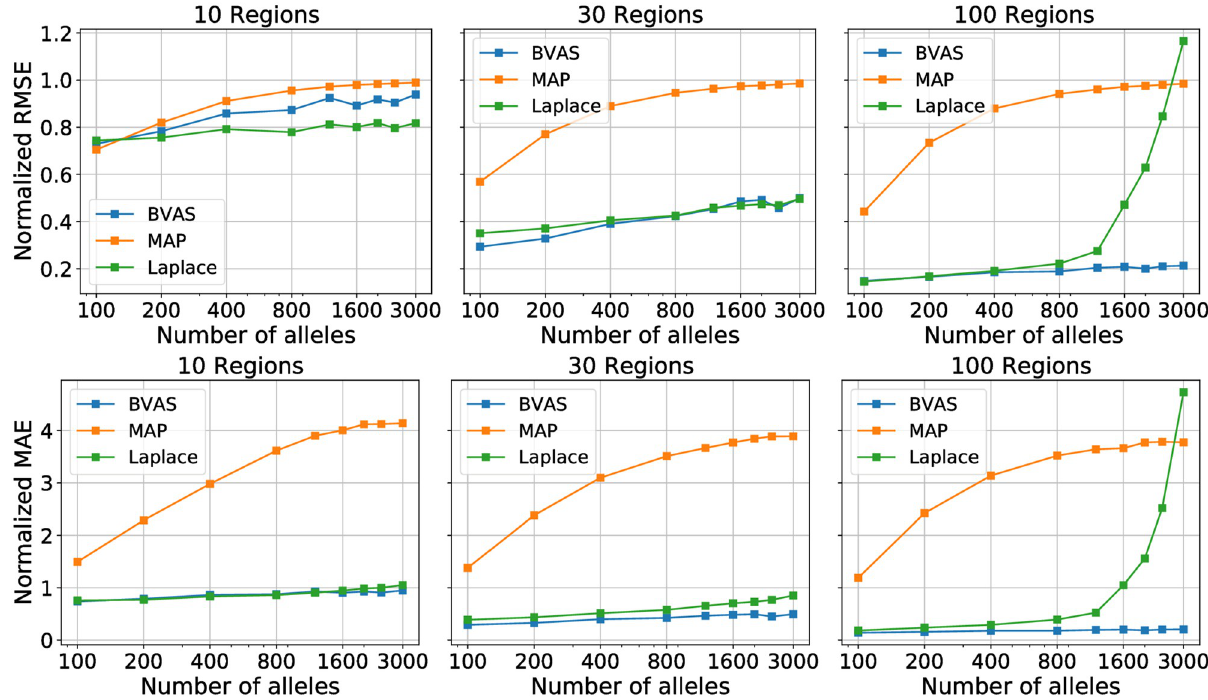
Fig 2. Coefficient accuracy comparison. We report the accuracy of inferred selection coefficients β for three diffusion-based methods using the simulated data described in Sec. 3.1. We consider two metrics: root mean squared error (RMSE; top) and mean absolute error (MAE; bottom). In both cases the metric is normalized such that the value of the metric for β = 0 is equal to unity. For example, the RMSE is normalized by || β � || 2 , where β � are the true effects. We do not include a comparison to PyR 0 , since it utilizes a somewhat different likelihood, making direct comparison subtle. See Sec. 3.2 for